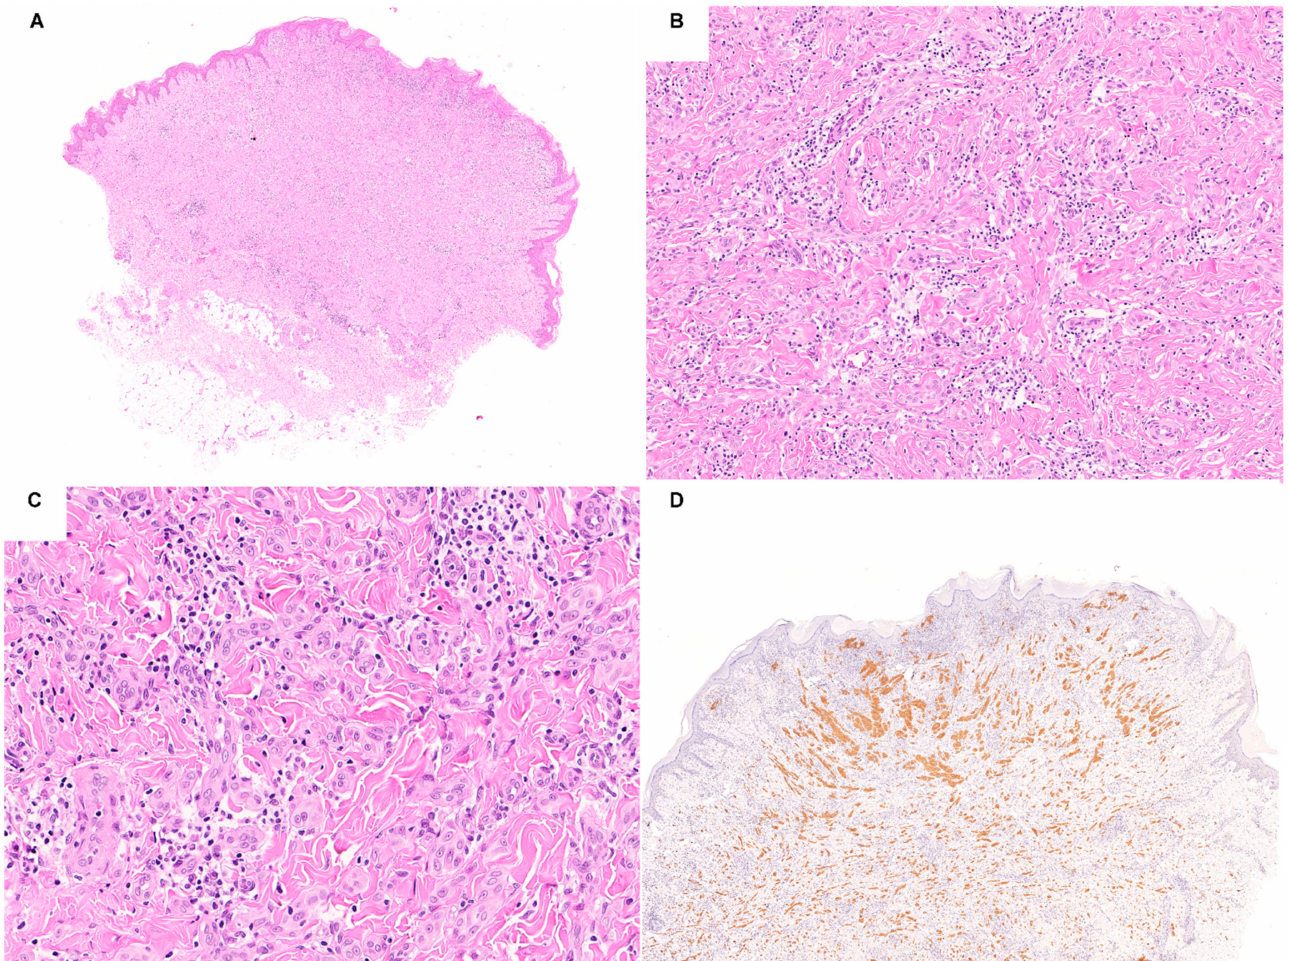
Figure 3. Photomicrographs of a Spitz nevus harboring ALK fusion showing a large, exophytic and dermal melanocytic proliferation with infiltrative base, composed of nonpigmented, large, epithelioid and spindle melanocytes with amphophilic cytoplasm, vesicular nuclei, and prominent nucleoli, arranged in plexiform intersecting fascicles ( A – C ) H&E staining; original magnification 10 × , 100 × , and 200 × , respectively). ALK (clone D5F3) immunohistochemistry showing a diffuse cytoplasmic staining (( D ) original magnification 12.5 ×